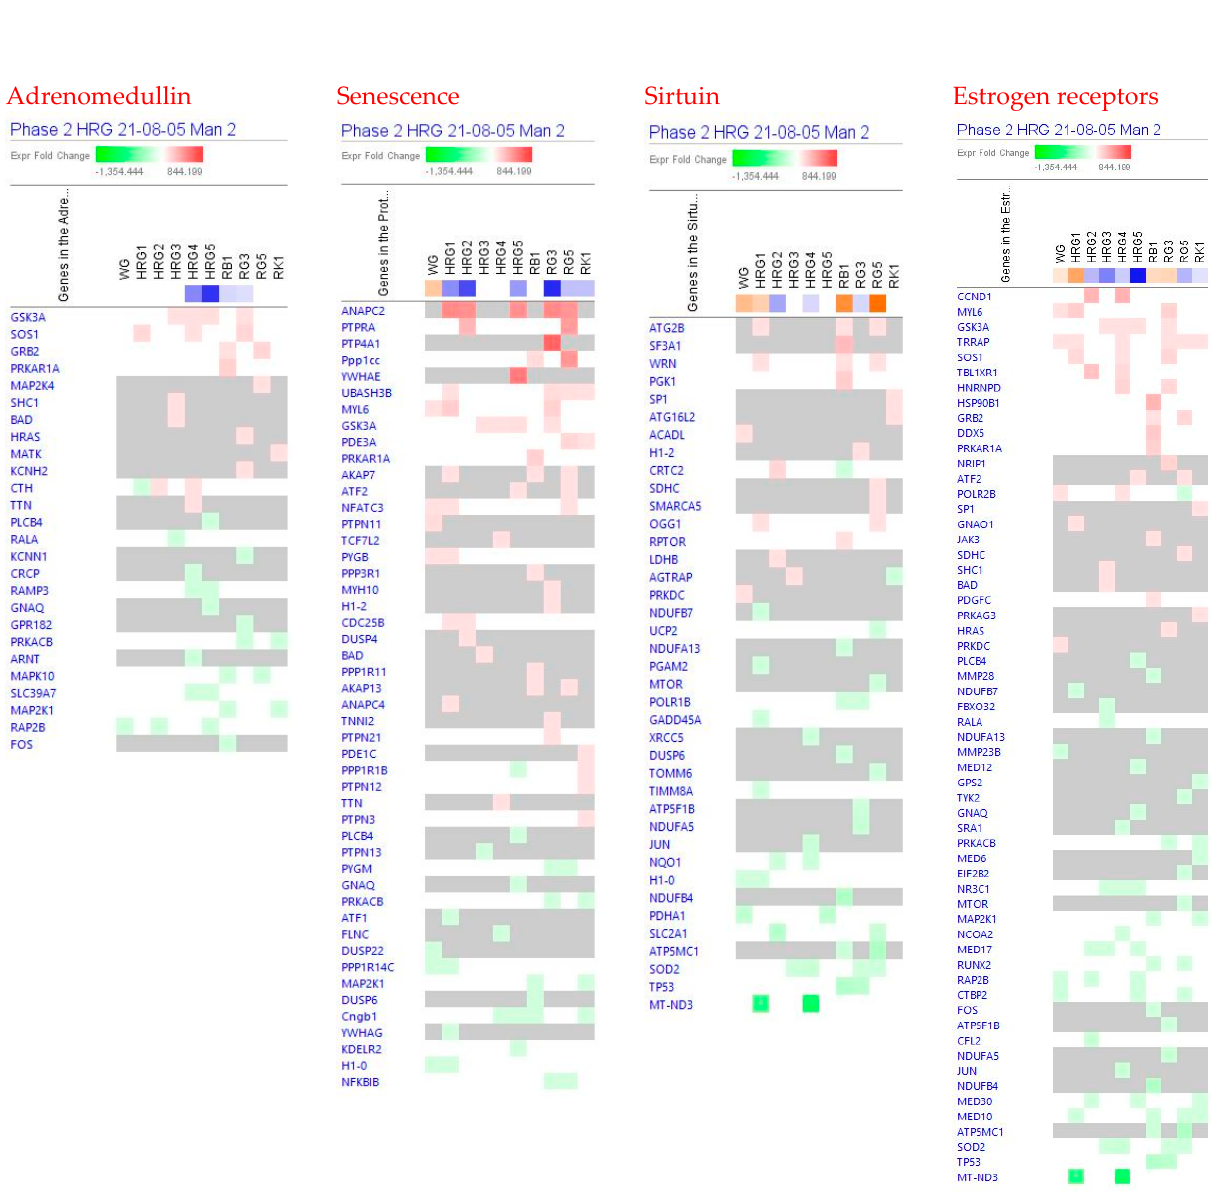
Figure 4. Effects of WG at a concentration of 10 µ g/mL, HRG at concentrations of 10 µ g/mL (HRG1), 1 µ g/mL (HRG2), 100 ng/mL (HRG3), 10 ng/mL (HRG4), and 10 pg/mL (HRG5), and ginsenosides Rb1, Rg3, Rg5 and Rk1 at a concentration of 100 nM on adrenomedullin, PKA, sirtuin and estrogen receptor-signaling pathways. The heatmap of gene expression (in fold-changes compared to control, red—upregulation, green—downregulation), after exposure of cells with test samples at different concentrations; the column represents signatures of test samples with solid red or green squares indicating genes that are expected to be upregulated or downregulated, respectively; color intensity indicates the actual log-fold changes.